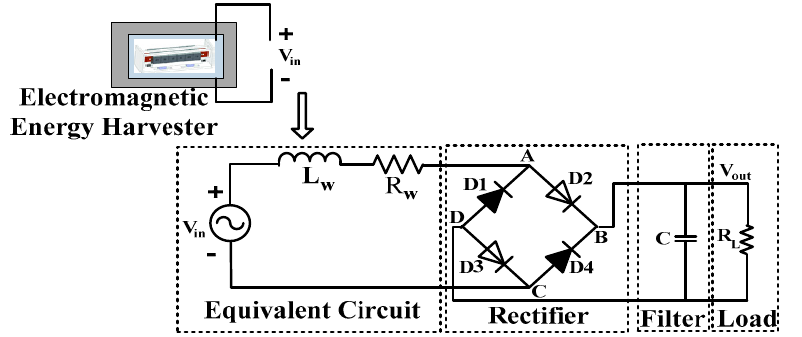
Figure 17. Corresponding symmetric diagram of electromagnetic energy harvesting system [28].